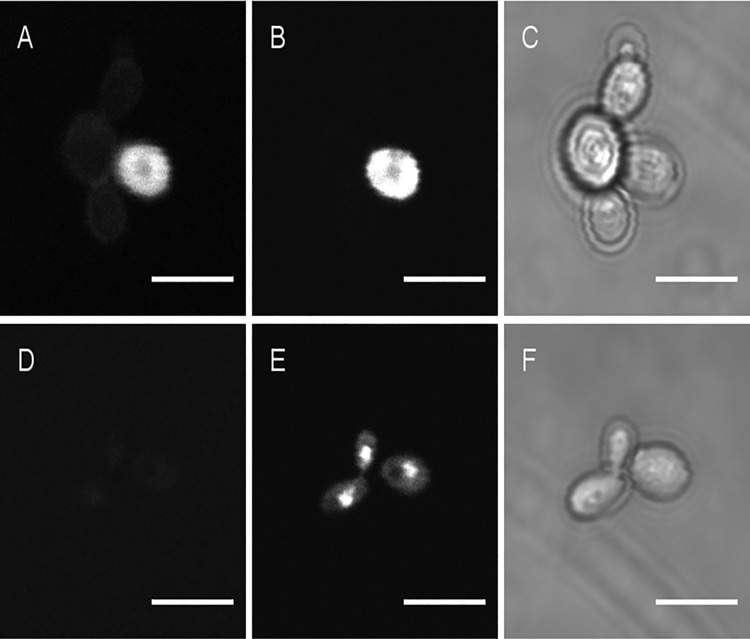
AMAC fluorescence (left panels, A and D), propidium iodide (PI) fluorescence (central panels, B and E) and transmission image (right panels, C and F) for C. guillermondii cells incubated for 24 hours with AMAC-labeled C32 (A, B, C) in RPMI medium. Ten minutes treatment with 50% ethanol (D, E, F) to provide a positive control for PI staining. The concentration of C32 was equal to the minimal inhibitory concentration. Scale bars represent 5μm.